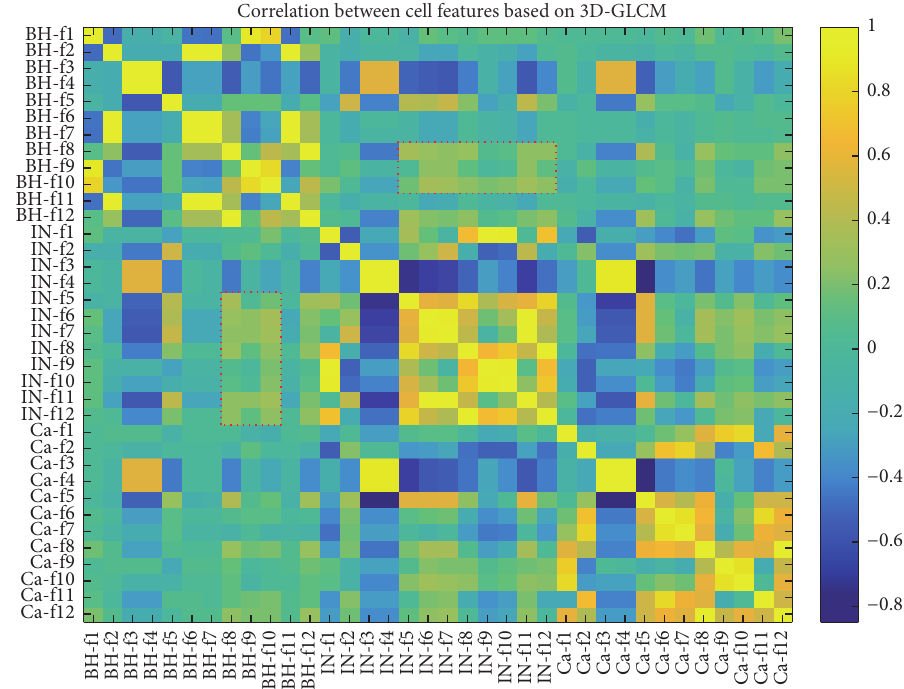
Figure 6: Heat map with correlation coefficients between ABC features: BH, IN, and Ca are the begin hyperplasia, intraepithelial neoplasia, and carcinoma, respectively. Red rectangular is the correlation effect of ABC feature which decreased the accuracy value of ABC